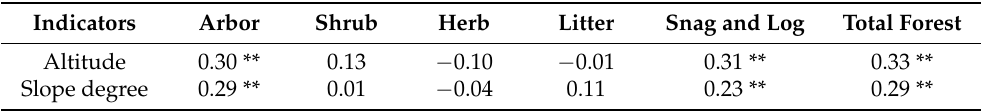
Table 8. Correlation coefficients between forest vegetation carbon density in each layer and altitude and slope